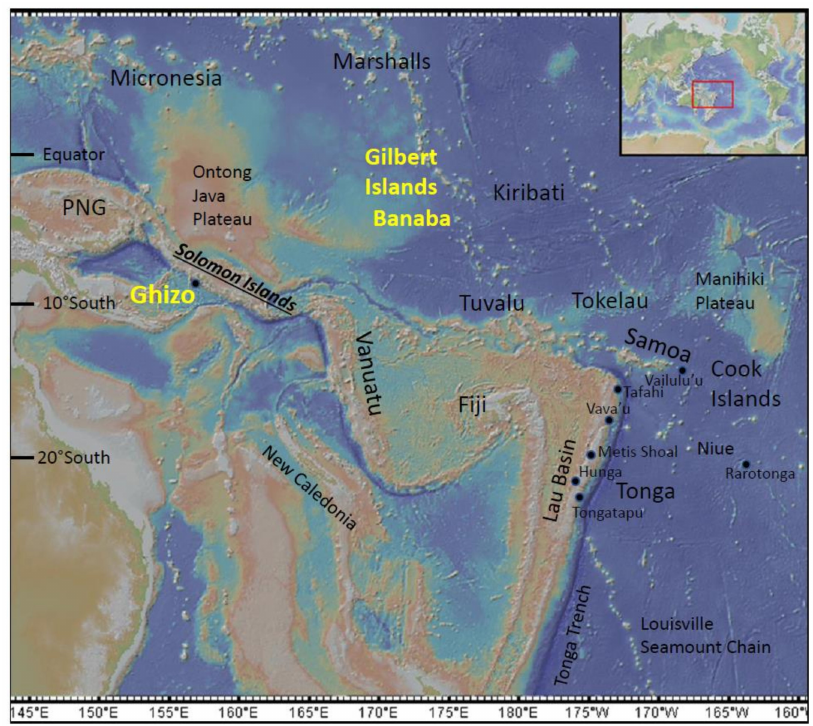
Figure 2. Overview map of the Pacific Islands region, illustrating key physiographic features of the region and the geographical positions of Solomon Islands, Kiribati, the Gilbert Islands and Banaba. Gilbertese Islanders were resettled to the Solomon Islands from the 1940s through to the 1970s, while Banaba Islanders were resettled to Fiji in